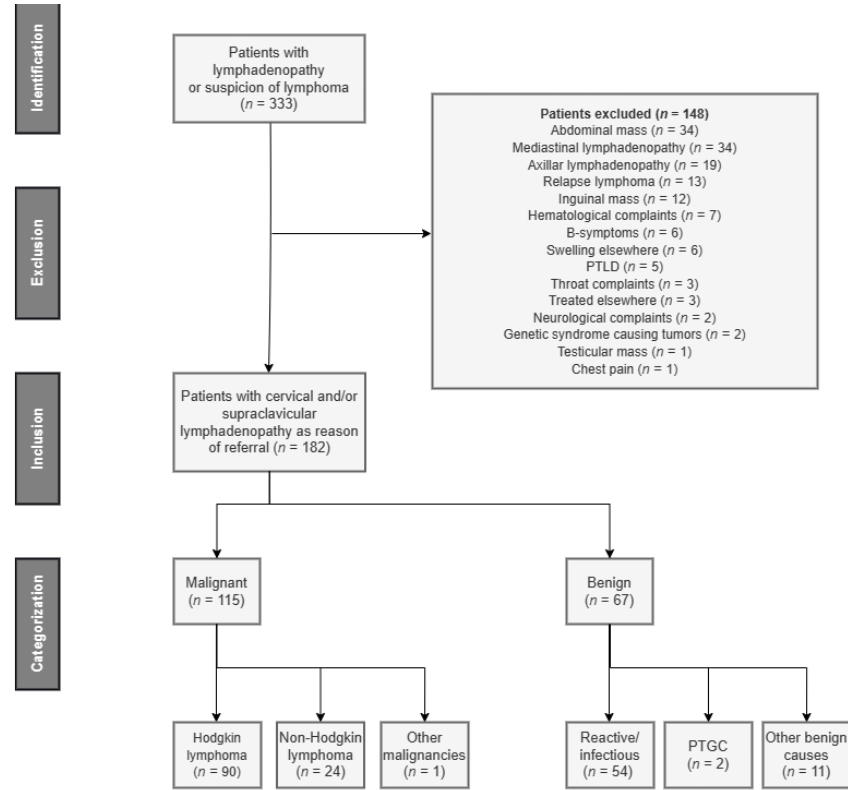
Figure 1. Flow diagram of study participants. In total, 333 patients were referred with lymphadenopathy. Of these, 151 patients were excluded based on our exclusion criteria. There were 182 patients referred with cervical/supraclavicular lymphadenopathy. Of these 182 patients, 115 patients were diagnosed with lymphoma and 67 with benign causes of lymphadenopathy. Abbreviations: PTLD—post-transplant lymphoproliferative disorders; PTGC—progressive transformation of germinal centers. Table 1. Baseline